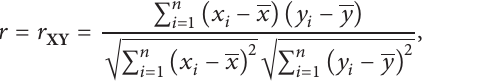
Figure 2: Frequency of each selected feature as relevant feature of a vocal test.